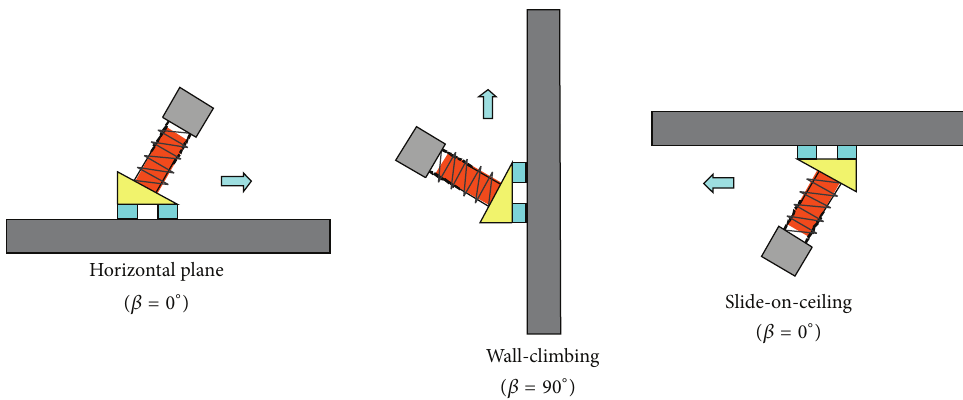
Figure 12: The magnetic actuator moving on iron